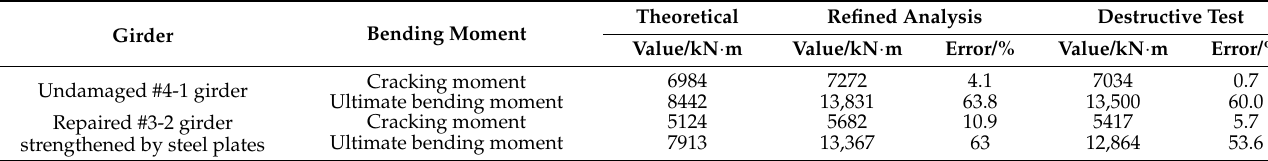
Table 5. Comparison of the predicted and experimental results.